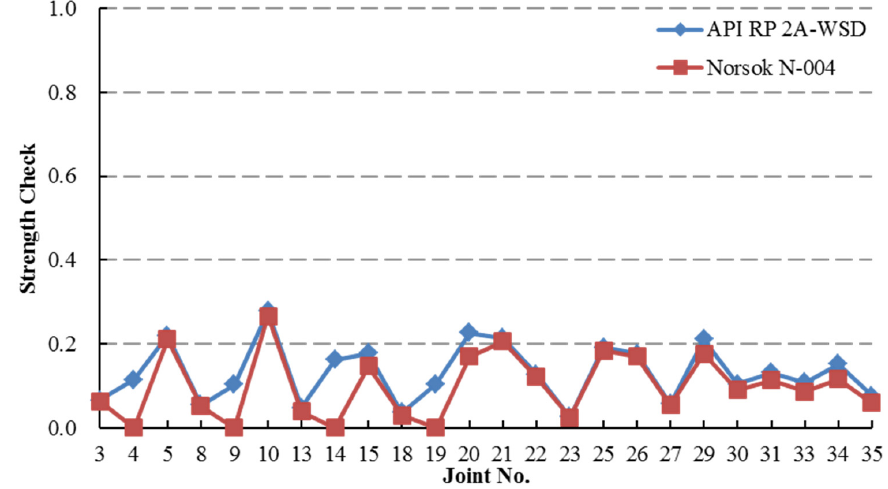
Figure 26. Joint Strength (Case 2).